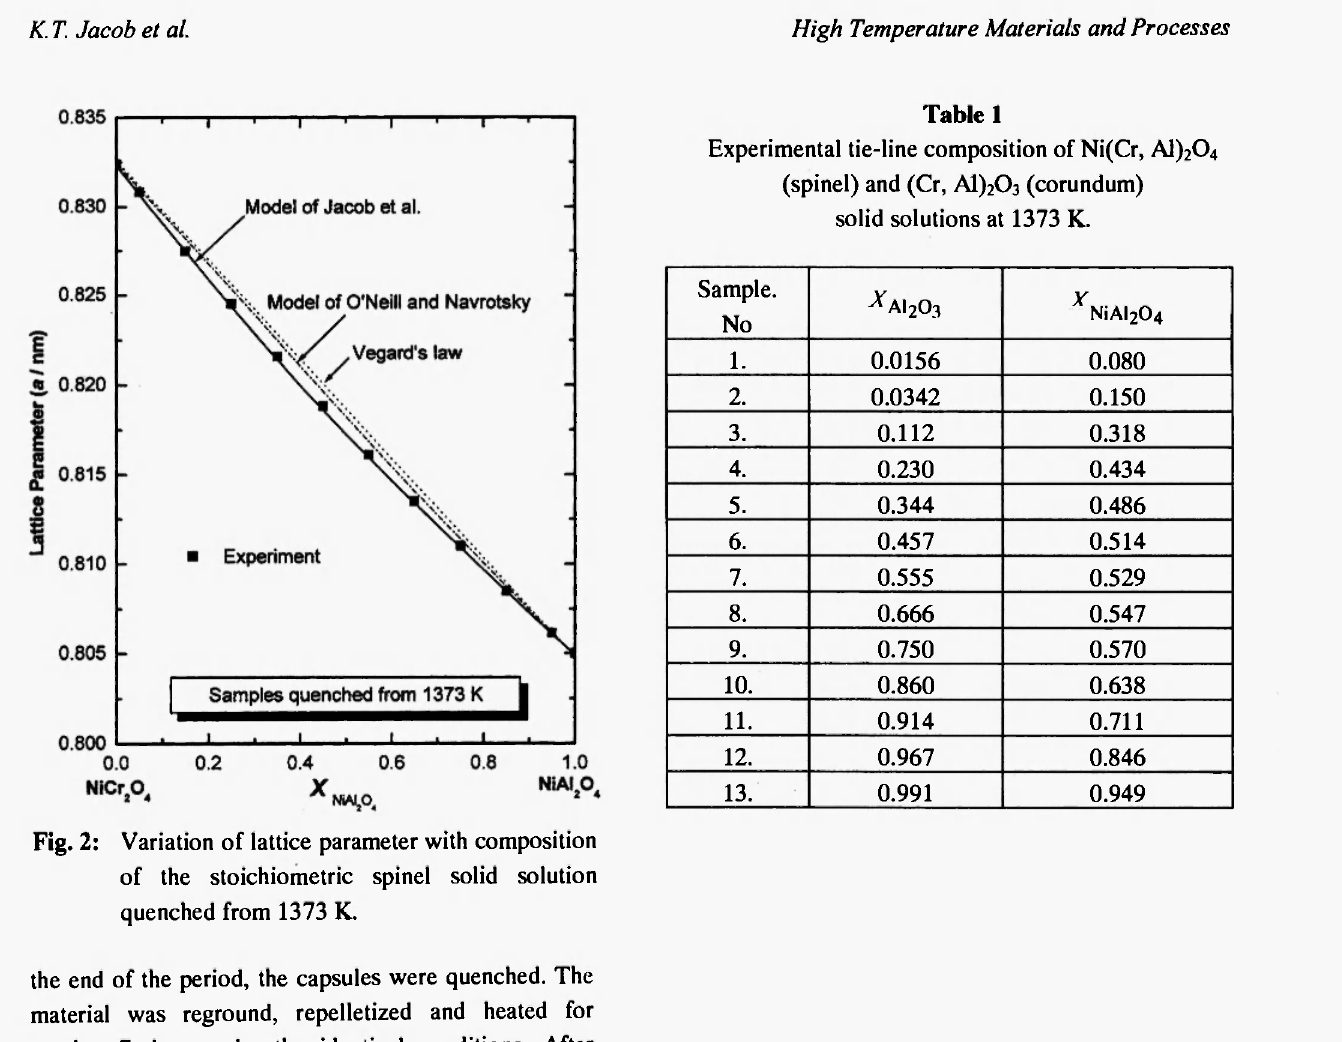
Fig. 2: Variation of lattice parameter with composition of the stoichiometric spinel solid solution quenched from 1373 K.